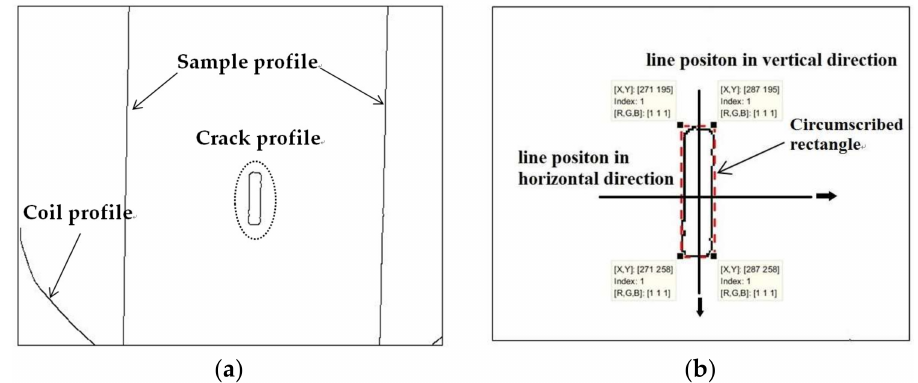
Figure 10. Edge detection results: ( a ) crack profile and ( b ) location of cracks and two straight lines.